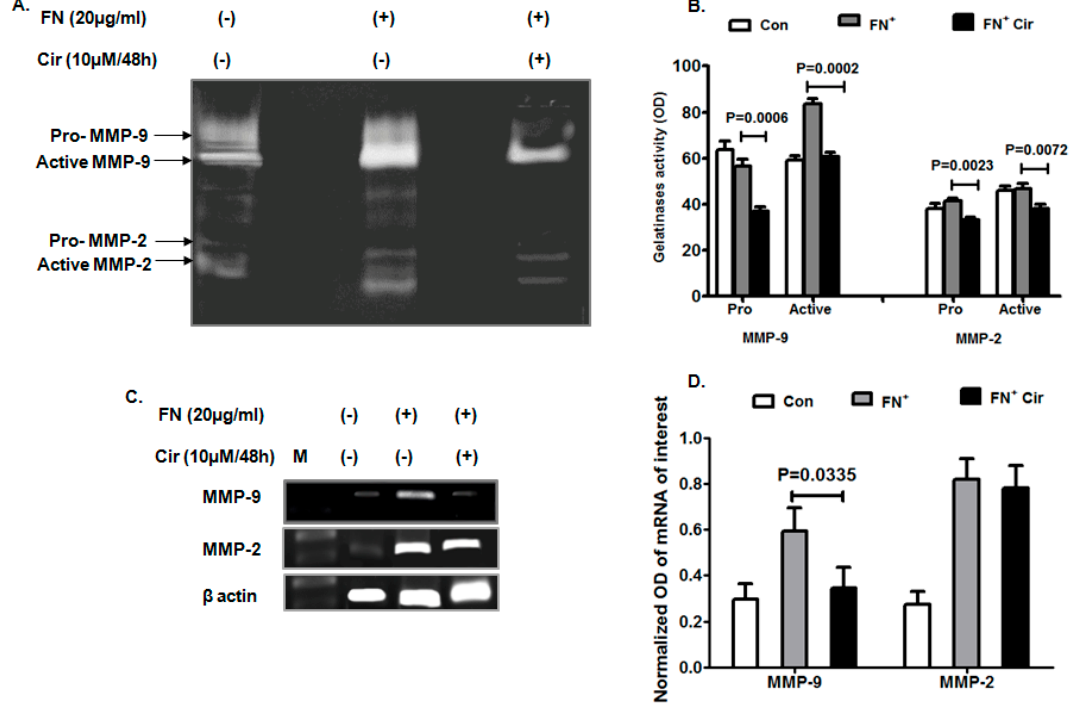
Figure 3. Effect of cirsiliol on gelatinases of B16F10 cells. ( A ) Representative zymogram elicited that FN-induced increase in activity of active MMP-2 and MMP-9 was significantly decreased when the cells were treated with FN + /Cir (10 µM/48 h). ( B ) Mean band intensities showed that FN + /Cir (10 µM/48 h) significantly inhibited activity of both pro and active forms of MMP-2 and MMP-9 than FN + - treated B16F10 cells. ( C ) Inhibition of MMP-9 expression by FN + /Cir (10 µM/48 h) with respect to FN + -induced cells. On the other hand, transcript profile of MMP-2 did not show any significant change of expression by FN + /Cir (10 µM/48 h) with respect to FN + -induced cells. ( D ) FN + /Cir (10 µM/48 h) caused significant inhibition of mean MMP-9 mRNA expression and no change of mean MMP-2 mRNA expression in comparison to only FN-induced cells. Cir: cirsiliol; FN + : cells were seeded in pre-coated (cellular FN 20 µg/mL for 2 h at 37 ° C) petri dishes and further incubated for 48 h in presence of 5% FBS for induction of EMT; FN + /Cir (10 µM/48 h): cells were seeded in pre-coated (cellular FN 20 µg/mL for 2 h at 37 ° C) petri dishes and treated with subjected to a non-cytotoxic dose of cirsiliol (10 µM) treatment for 48 h; M: DNA step ladder 100 bp. All quantitative results are expressed as mean±SD based on three replicates.